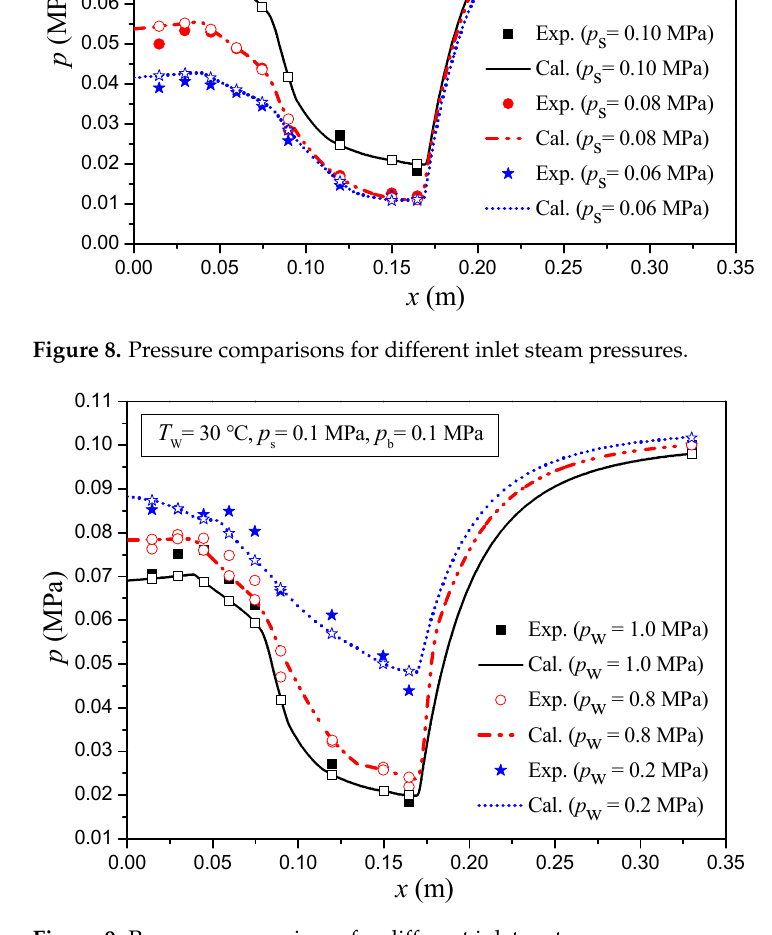
Figure 9. Pressure comparisons for different inlet water pressures.